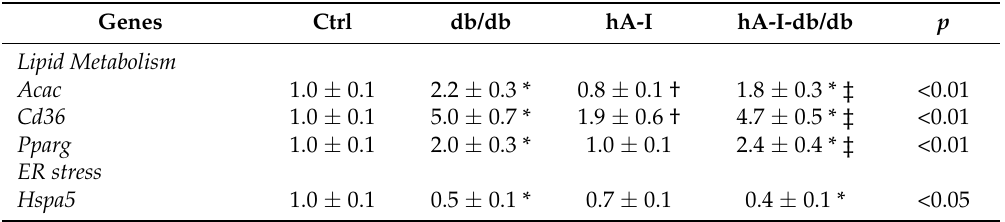
Table 2. Hepatic gene expression profile of molecular targets involved in lipid metabolism and endoplasmic reticulum (ER)